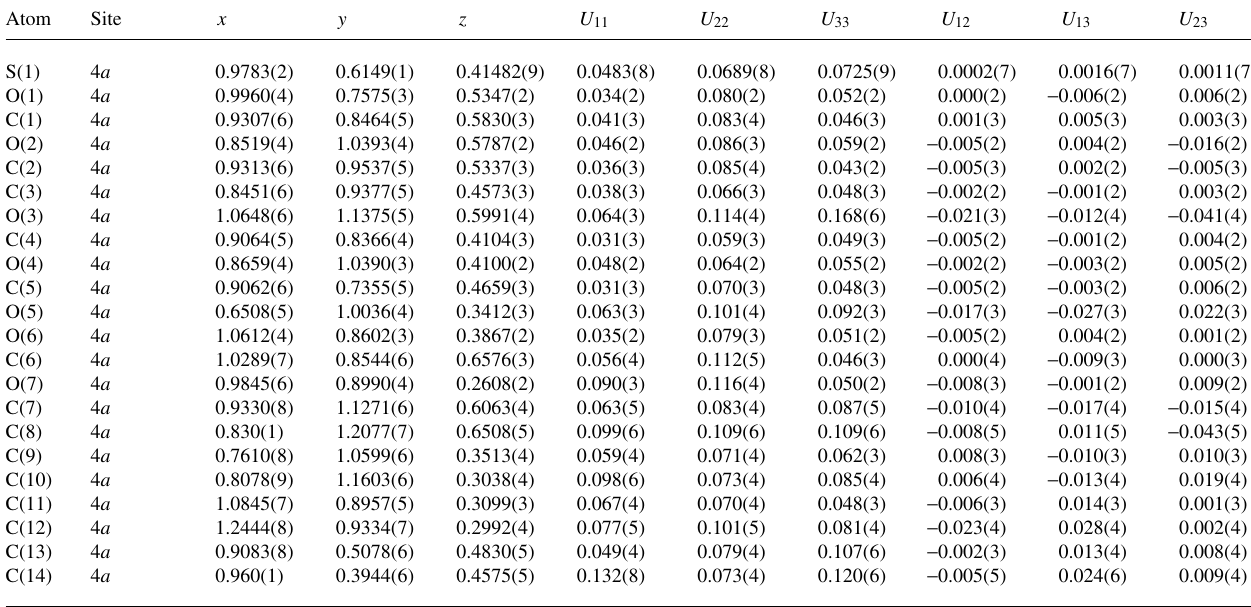
Table 3. Atomic coordinates and displacement parameters (in Å 2 )